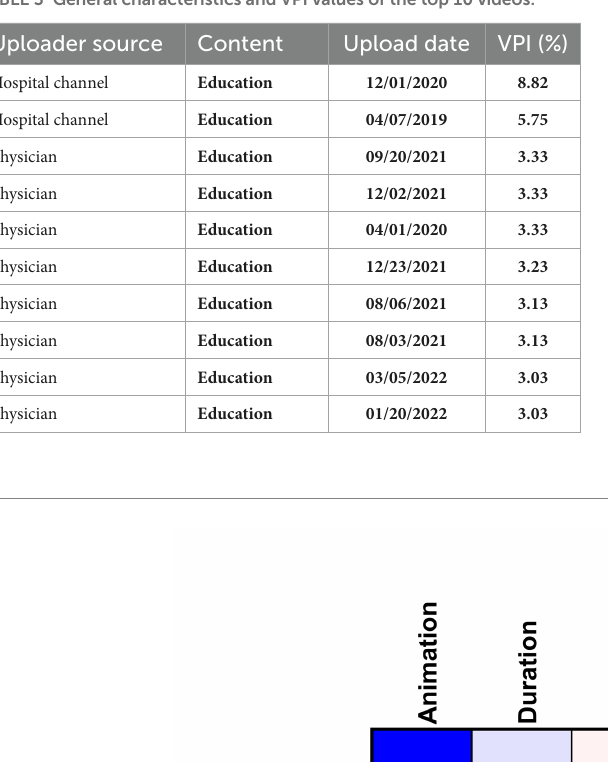
(53/56, 94.6%), signs and symptoms (50/56, 89.3%), management (52/56,